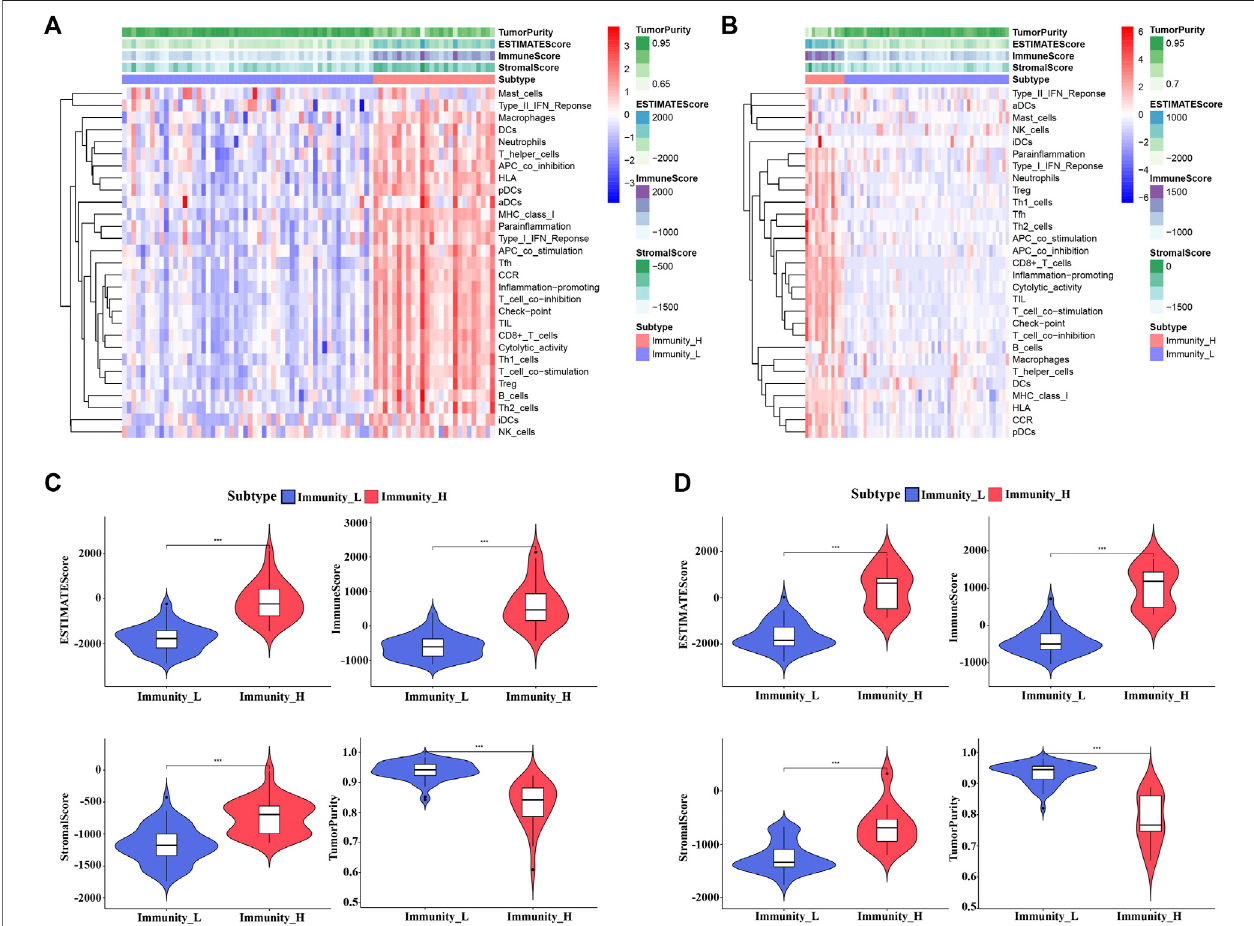
FIGURE 2 | Construction and evaluation of UVM clusters. (A,B) The enrichment levels of 29 immune-associated gene sets in the low (Immunity_L) and high (Immunity_H) immune cell in fi ltration groups in TCGA_UVM cohort (A) and GSE22138 cohort (B) . (C,D) The violin plot showed the difference in ESTIMATE Score, Immune Score, Stromal Score, and Tumor Purity between two clusters in TCGA_UVM cohort (C) and GSE22138 cohort (D) .